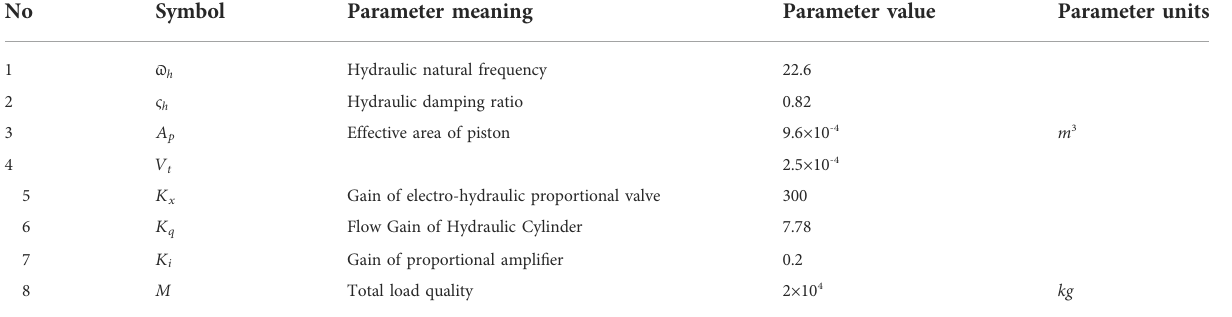
TABLE 6 DOA 090470 − 1 ( 1 ) hydraulic cylinder parameter table.